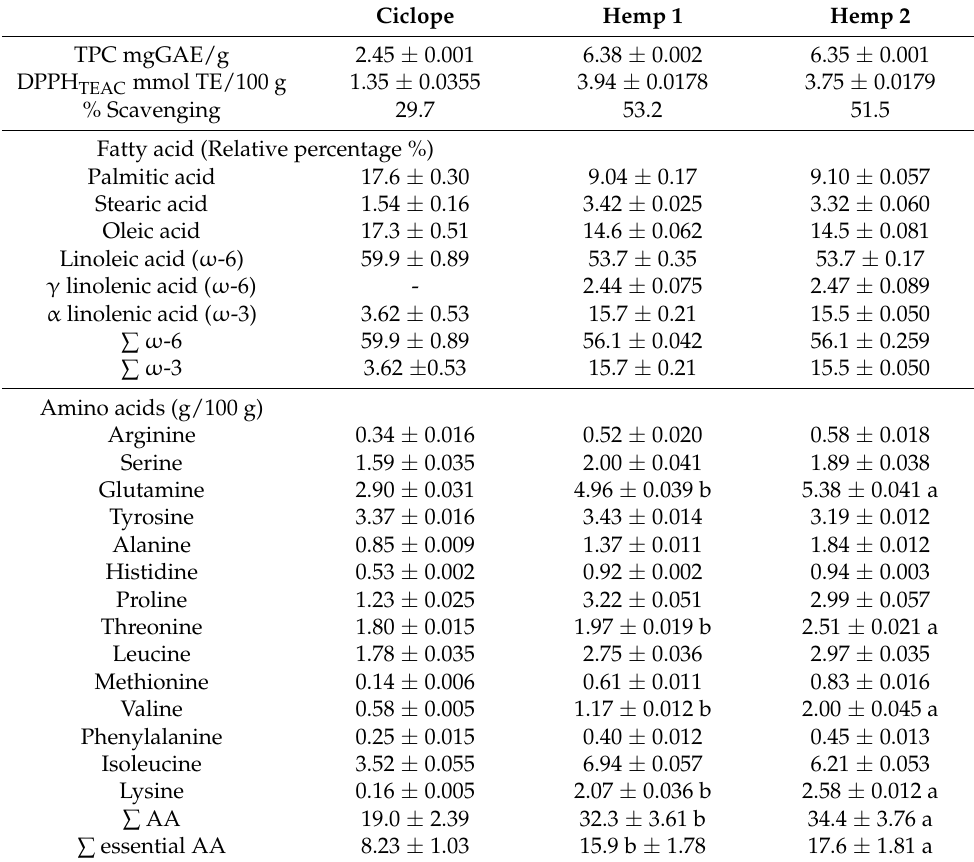
Table 4. Chemical characterization of raw